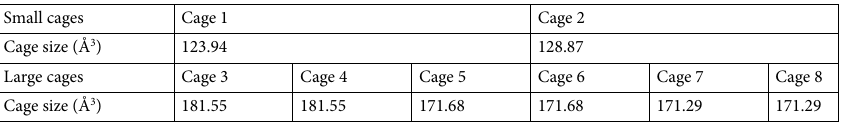
Table 1. Cage sizes for empty sI hydrate under 4.6 GPa, where the empty hydrate can support the maximum compressive pressure. Cages 1 and 2 are the small cages, and cages 3–8 are the large